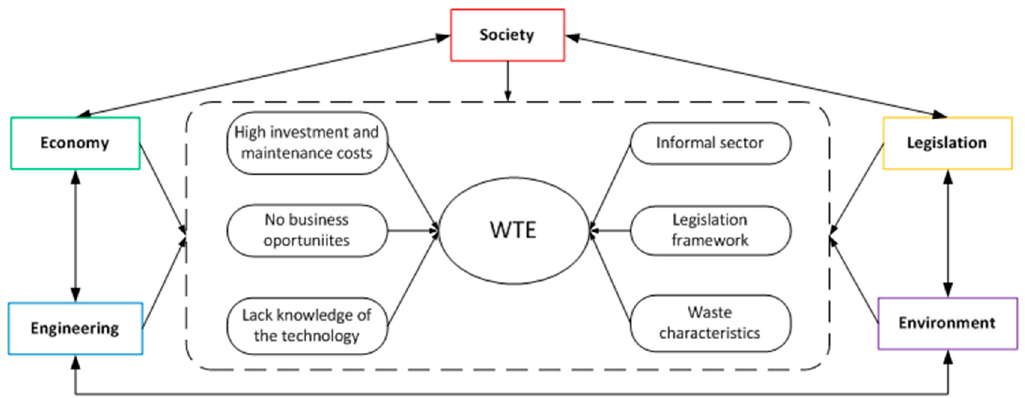
Figure 2. Disciplines and barriers considered for WTE in low- and middle-income countries.